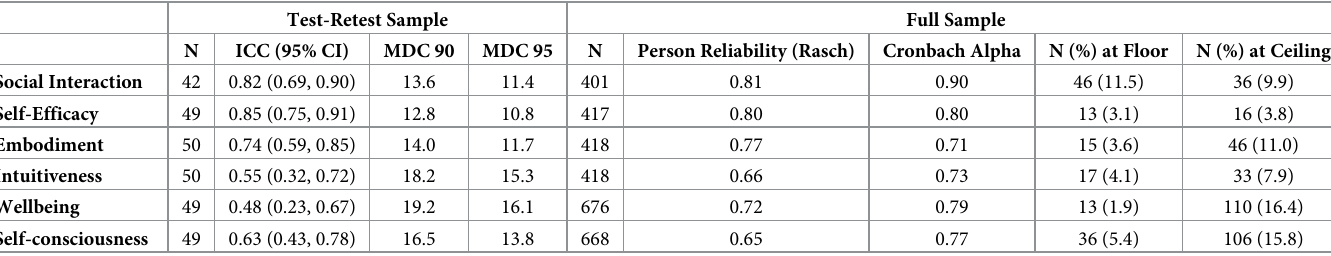
Table 7. PEM subscale ICCs, MDCs, person reliability, Cronbach alphas, and floor and ceiling